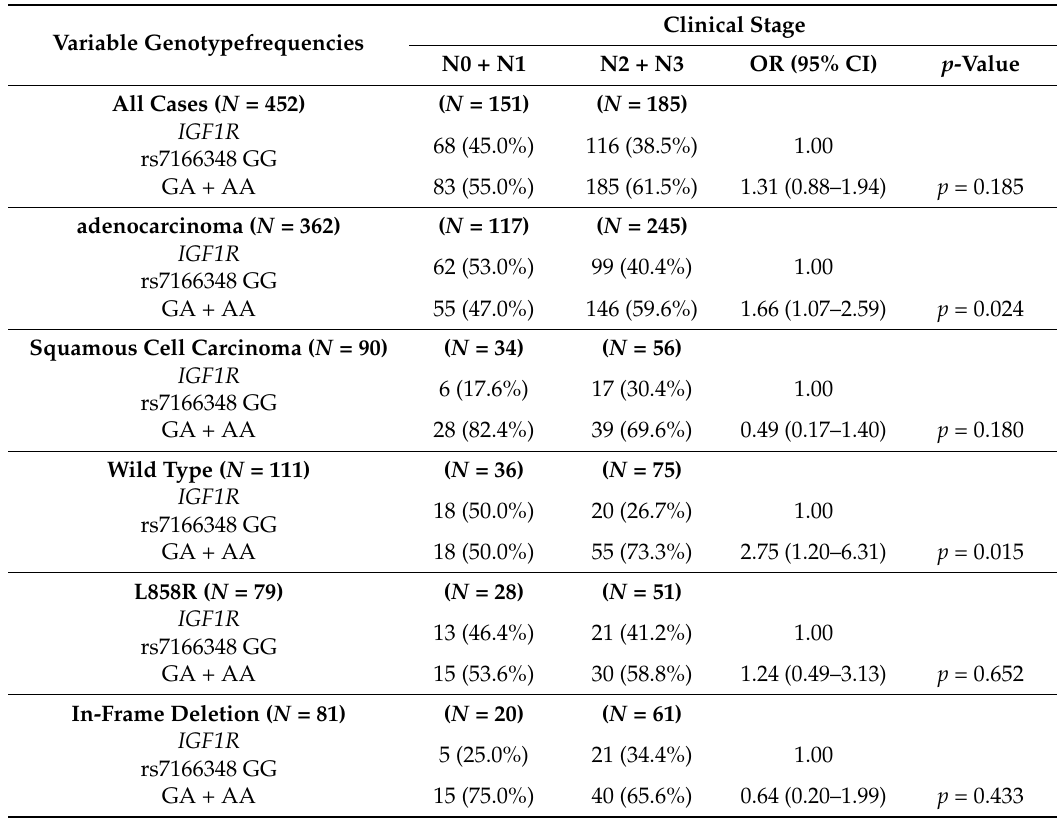
Table 6. Associations between polymorphic genotypes of IGF1R rs7166348 and clinicopathologic characteristics of lung